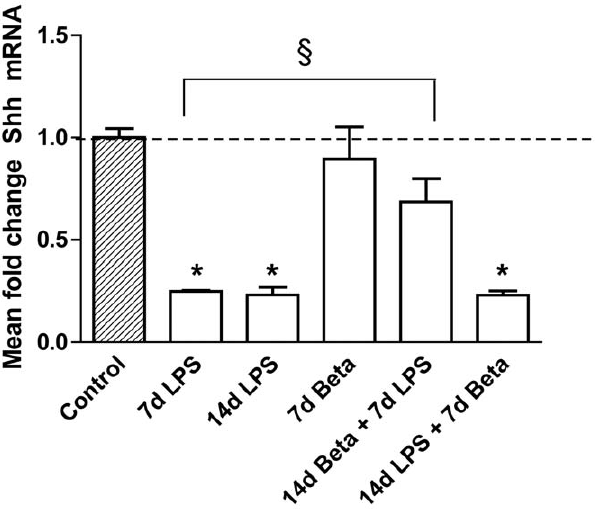
Figure 7. Sonic Hedgehog (Shh) mRNA expression. The mRNA levels of Shh were significantly decreased after 7 d and 14 d LPS exposures and in the 14 d LPS + 7 d Beta group. * p , 0.05 versus controls and 1 p , 0.05 between experimental